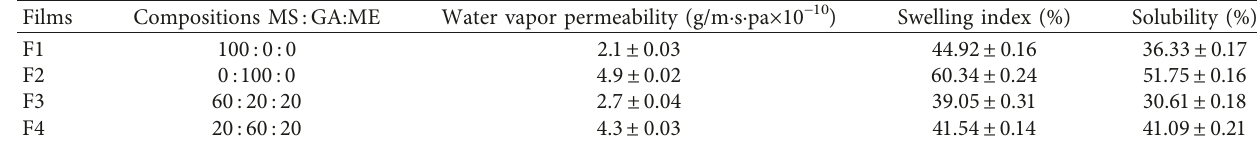
Table 2: Water vapor permeability, swelling index, and solubility of the